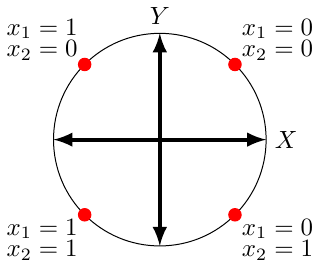
FIG. 2. The four red dots correspond to the four states defined in Eq. (1) depicted as points on the equator of the Bloch sphere.